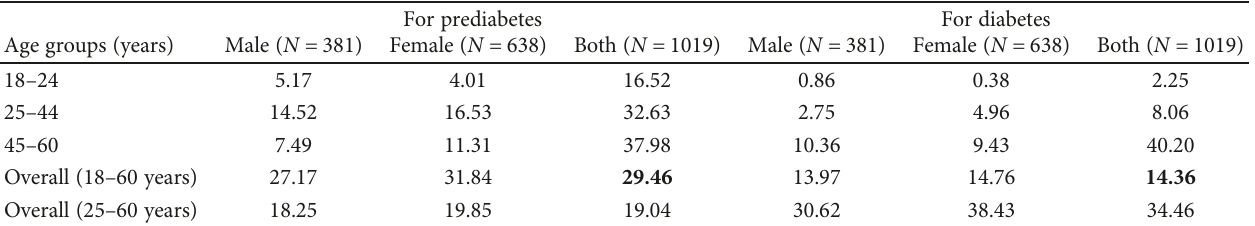
Table 3: Prevalence (%) of prediabetes and diabetes adjusted to national population of Saudi Arabia. For prediabetes For